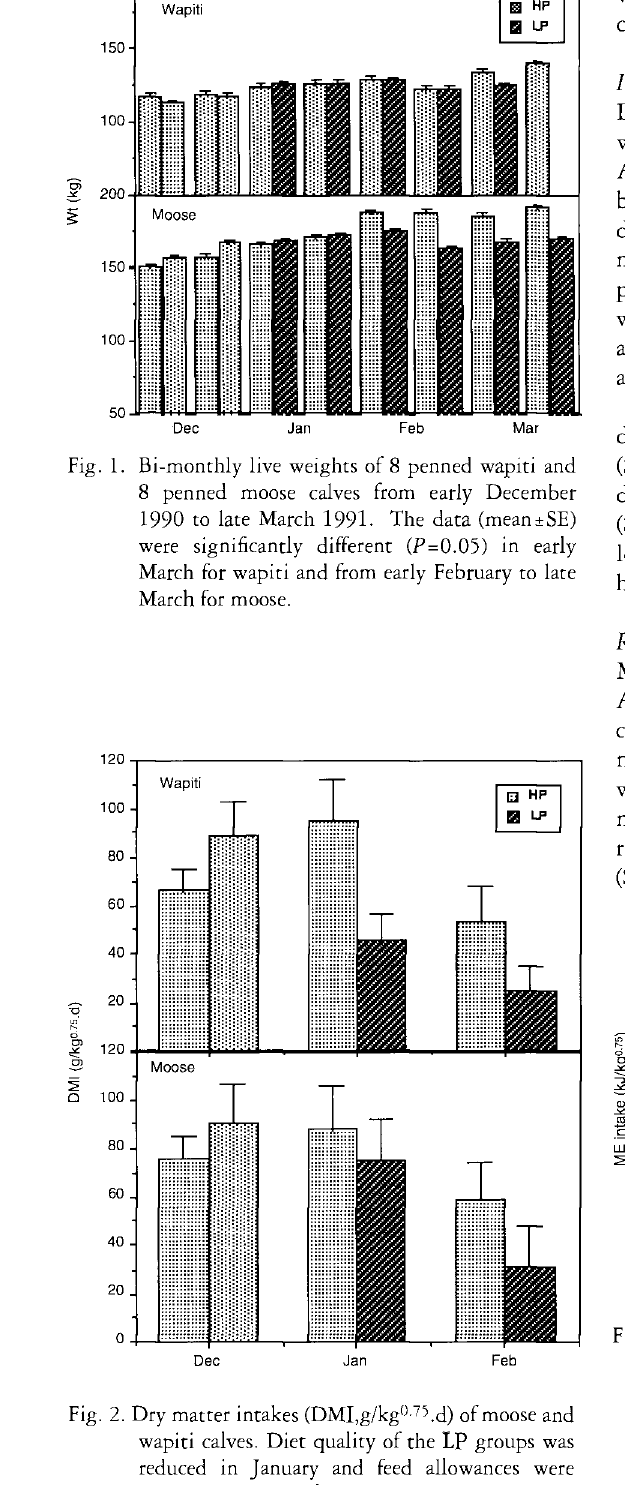
Fig. 2. Dry matter intakes (DMI,g/kg°- 75 .d) of moose and wapiti calves. Diet quality of the LP groups was reduced in January and feed allowances were reduced to 50% ad libitum in February.